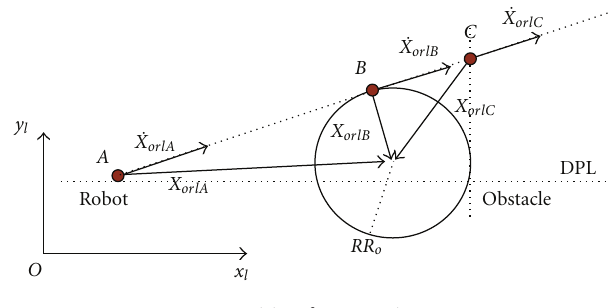
Figure 11: Position for returning to